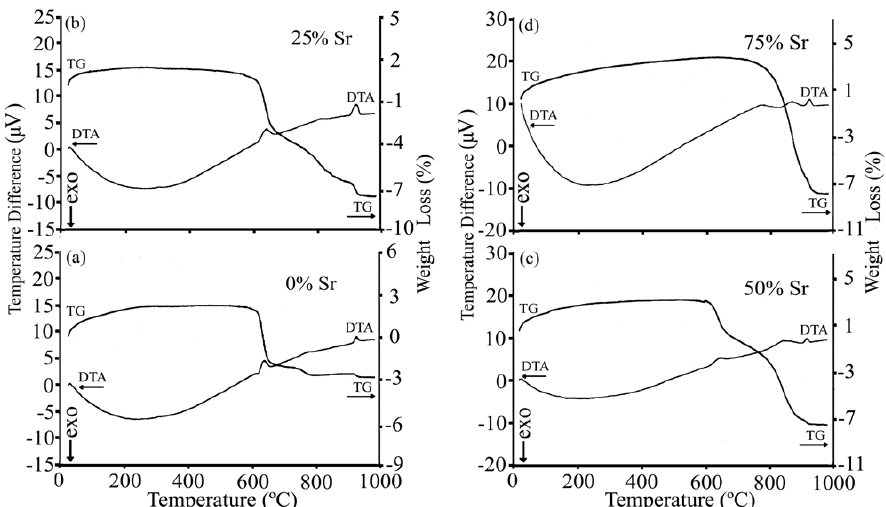
Figure 2. TG and DTA profiles of (a) LaCoO